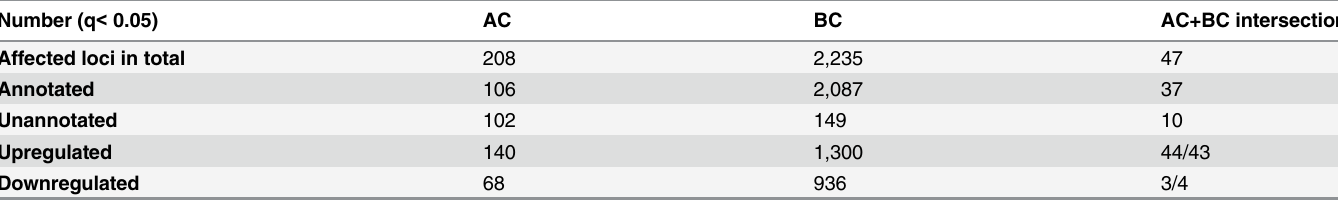
Table 2. Summary of number of loci modulated on expression level in response to vaccination in cows prior to and after calving. Number (q <